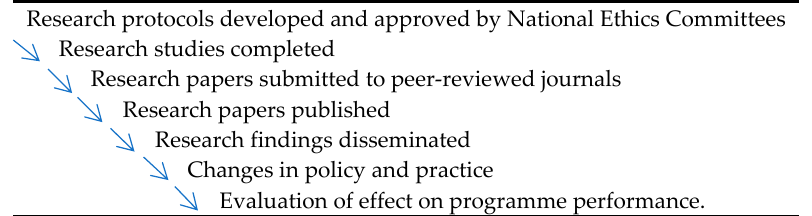
Table 7. Proposed framework for the regular evaluation of operational research within a National TB Programme.